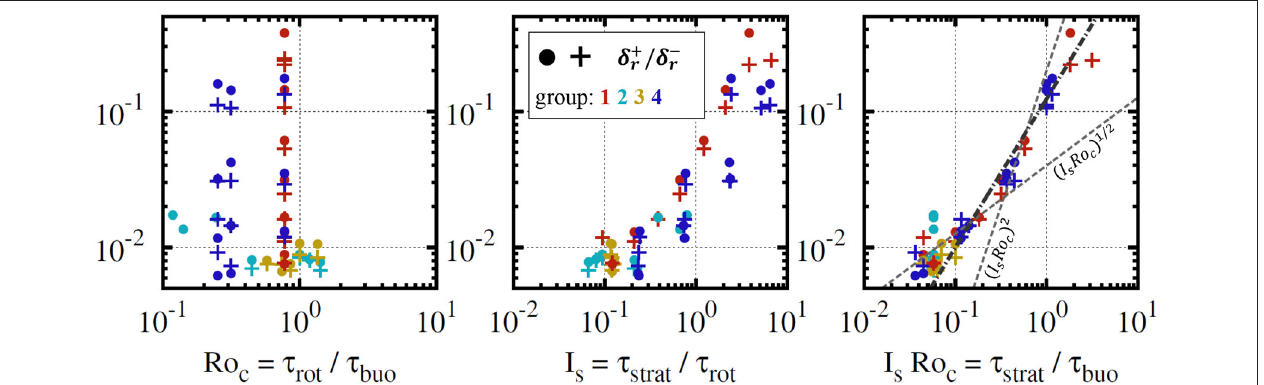
FIGURE 10 | Mean penetration depth at the lower edge ( δ + r , filled circles) and upper edge ( δ − r , plus markers) as a function of time scale ratios. Plotted are models from Table 1 , colors indicate various groups. For the right hand plot a power law is fitted to the data for I s Ro c > 0.1 (thick black, dot-dashed line), showing the I s Ro c . The thin gray power laws indicate previously published scaling suggestions. For details, see almost linear dependence of δ r ∝